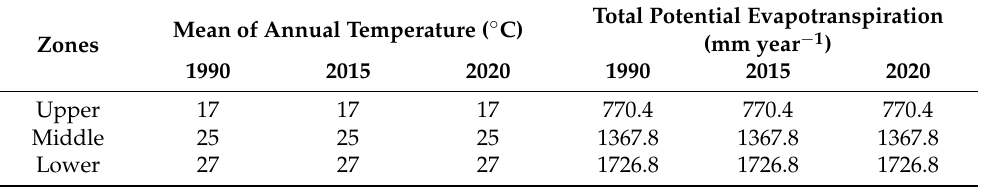
Parameter estimates for actual/potential evapotranspiration ( ε ) and runoff coefficient ( ρ ) were derived as area-weighted average from estimate for the specific land use types in the GenRiver model, calibrated for a number of Indonesian watersheds